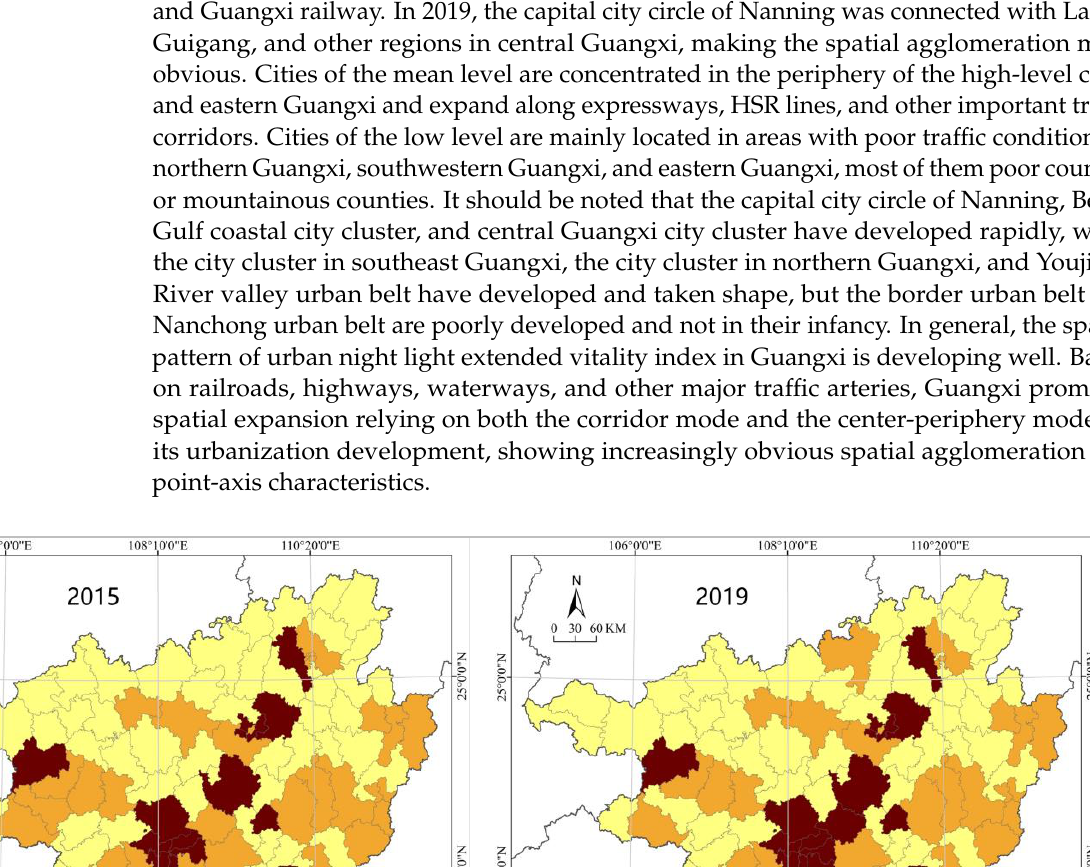
Table 5. Spatial heterogeneity analysis of night light extended vitality index in Guangxi .